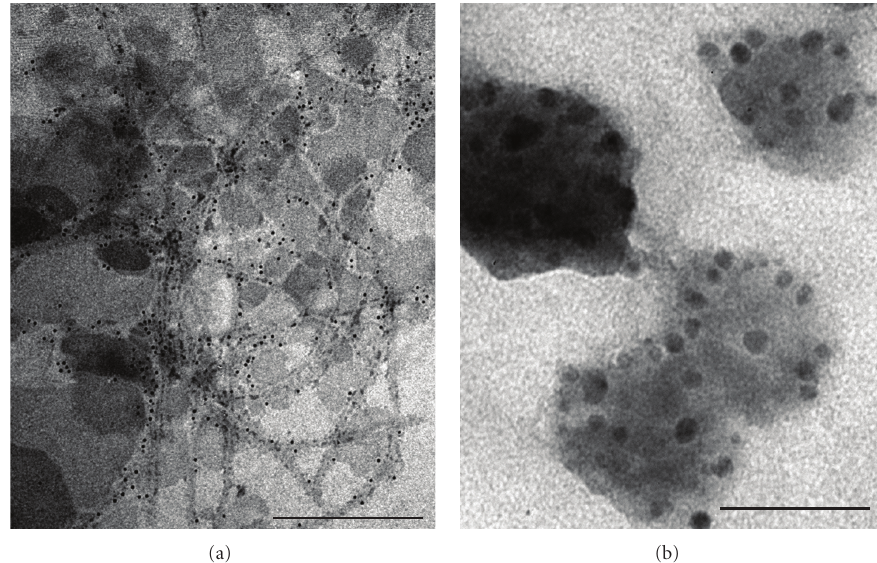
Figure 3: Immunogold EFTEM micrographs of sCT in mature fibres ((a) bar = 200 nm) and liposomes, where sCT is inserted in the lipid bilayer ((b) bar = 50 nm). Picture in (b) was reproduced with permission from